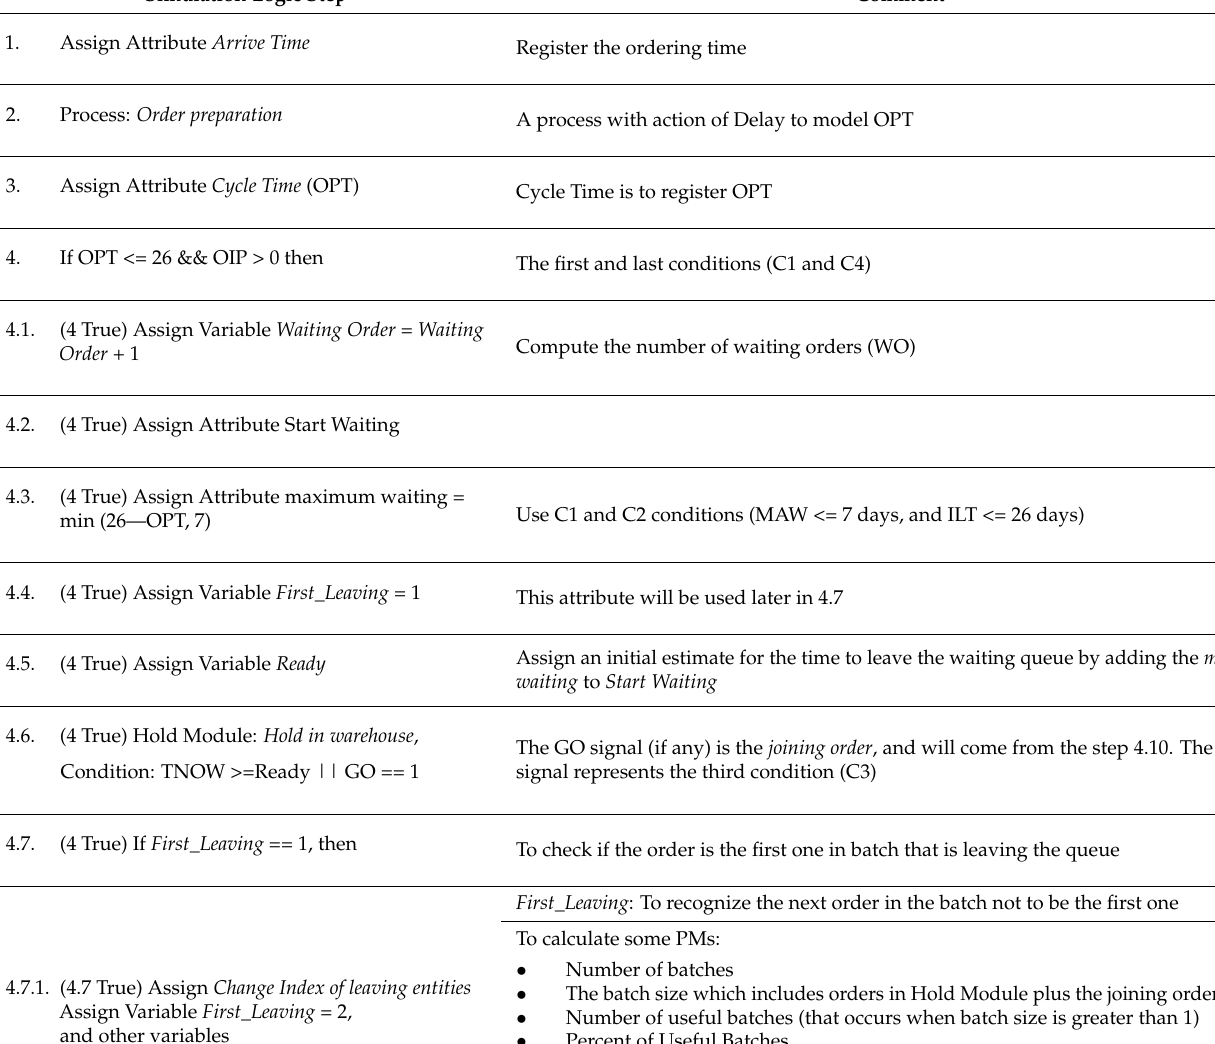
Table 1. Steps of the logic of Arena